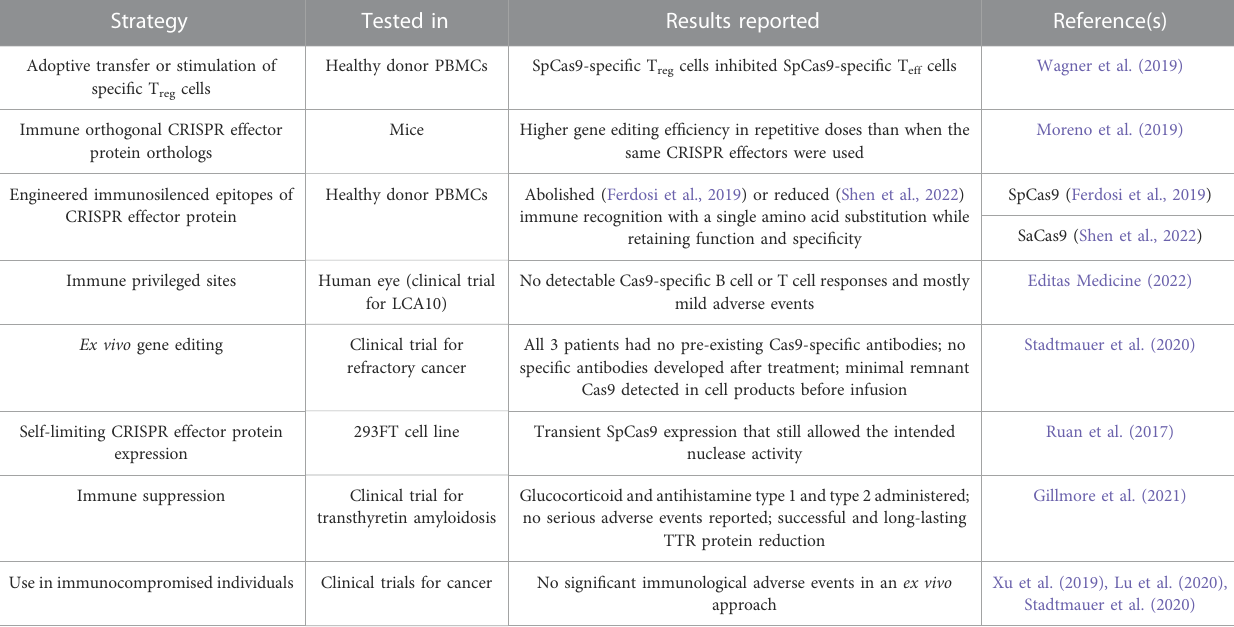
TABLE 2 Strategies for mitigating CRISPR effector-speci fi c immune responses.